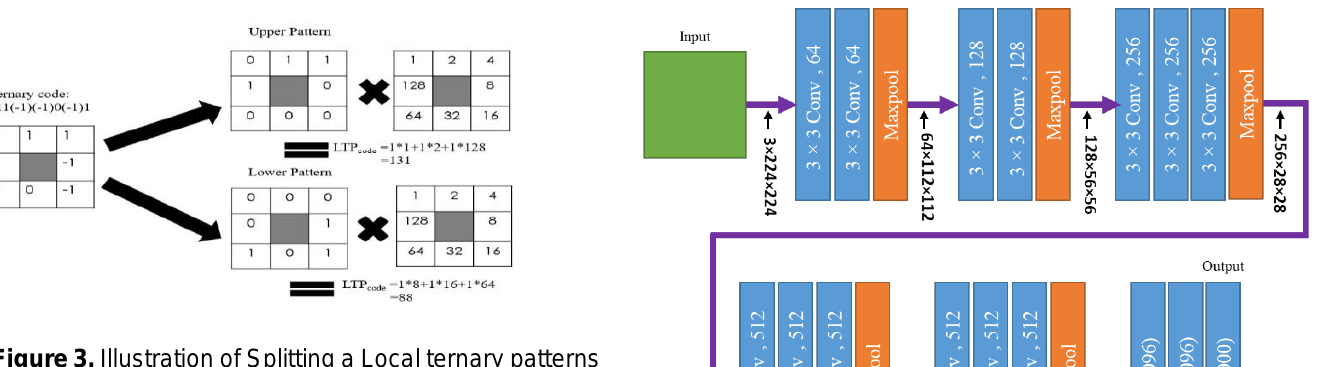
Figure 3. Illustration of Splitting a Local ternary patterns code into positive and negative code